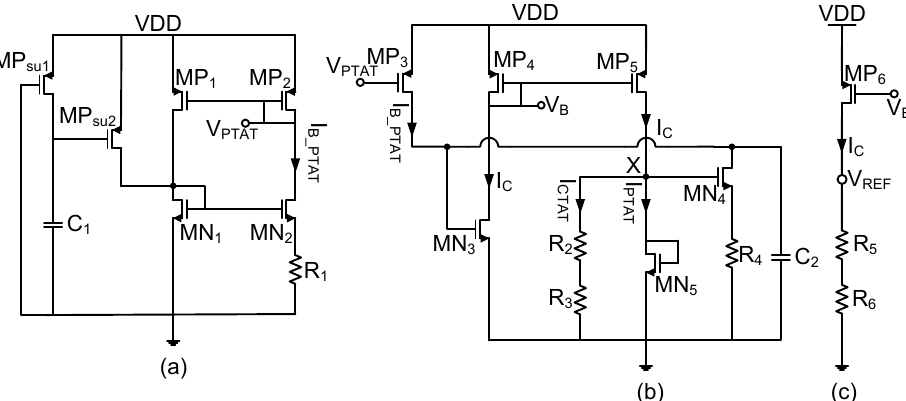
Figure 4. Schematic of the proposed voltage reference (VR2) [17]. ( a ) PTAT circuit including the start up (MPsu1, MPsu2,C1), ( b ) core module for implementing the high order compensation, ( c ) output stage to supply the reference